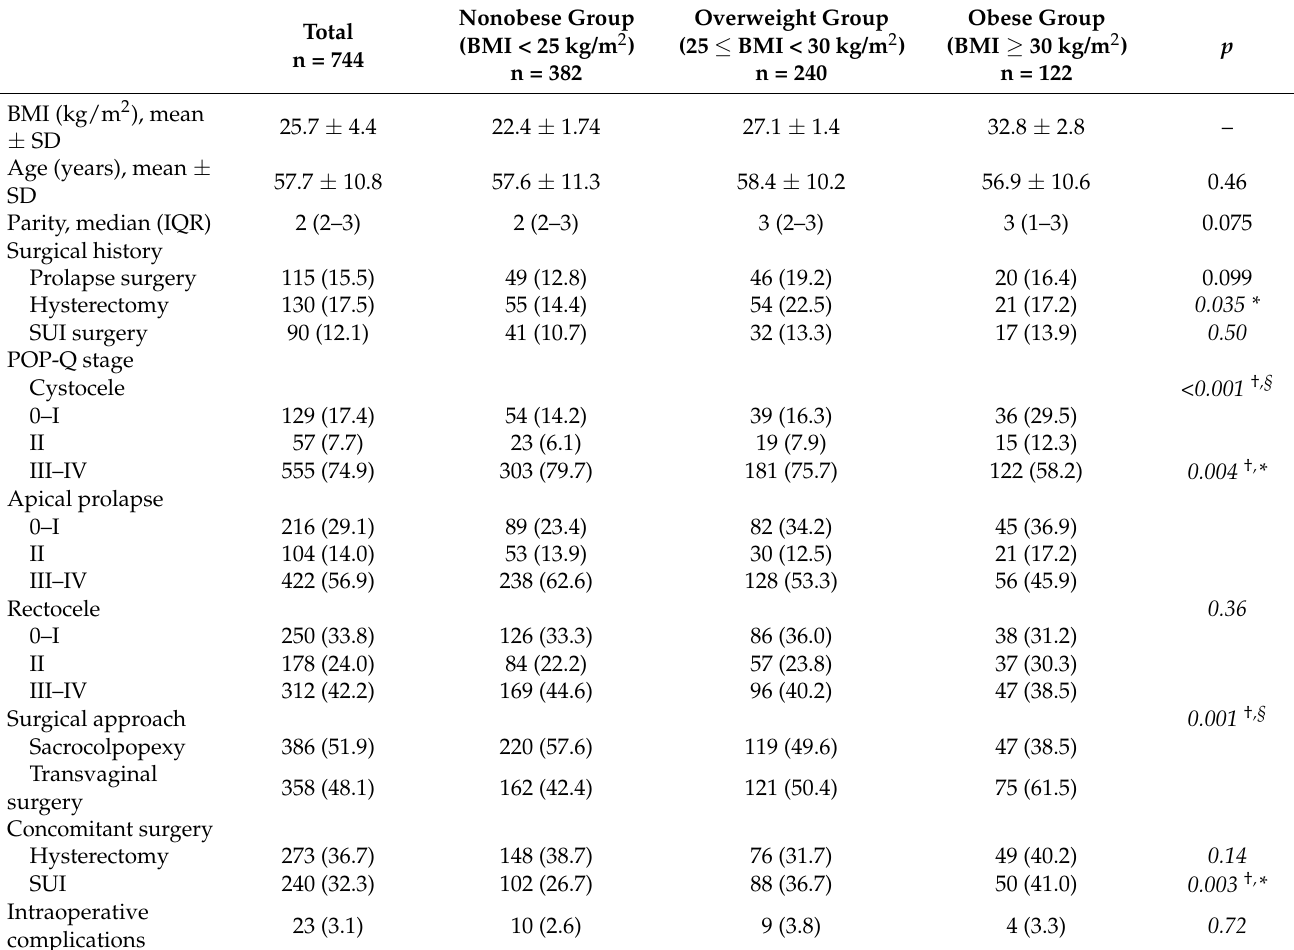
Table 1. Comparison of the baseline and surgical characteristics and intraoperative complications between the nonobese, overweight, and obese groups. Nonobese Group Overweight Total n = 744